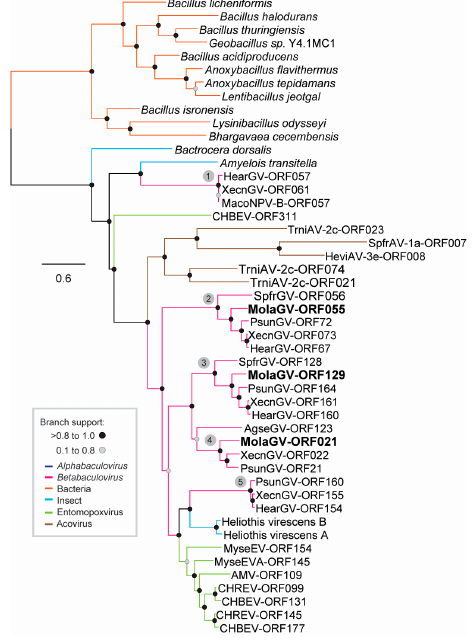
Figure 3. Recurrent duplication of an endonuclease -like gene in betabaculovirus. The phylogeny was based on the predicted amino acid sequence of Mola021, 055, and 129 homologs using